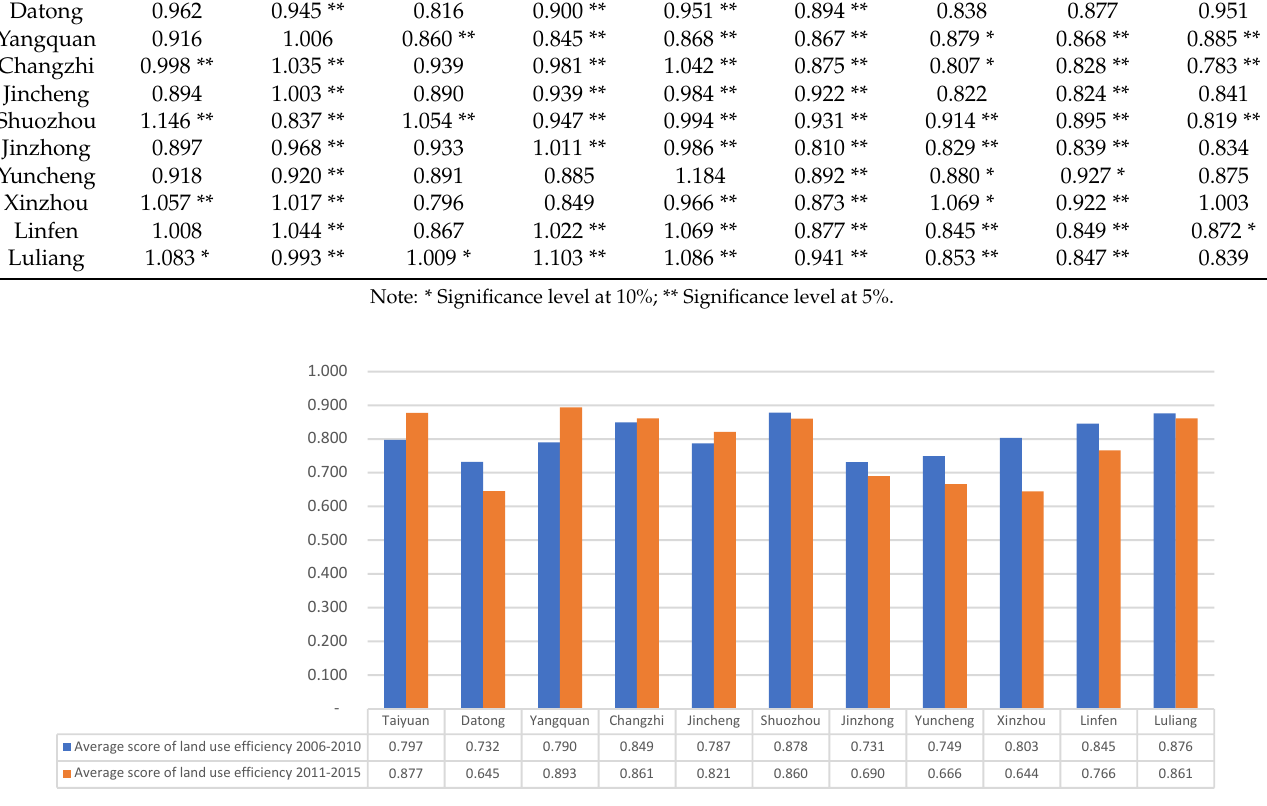
Figure 3. Comparisons between the average scores of land use efficiencies before and after the comprehensive economic transformation.